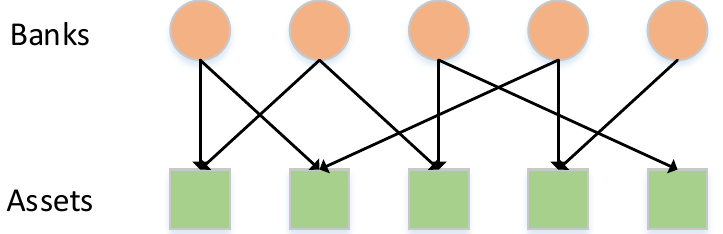
Figure 1. A bilateral network of banks and